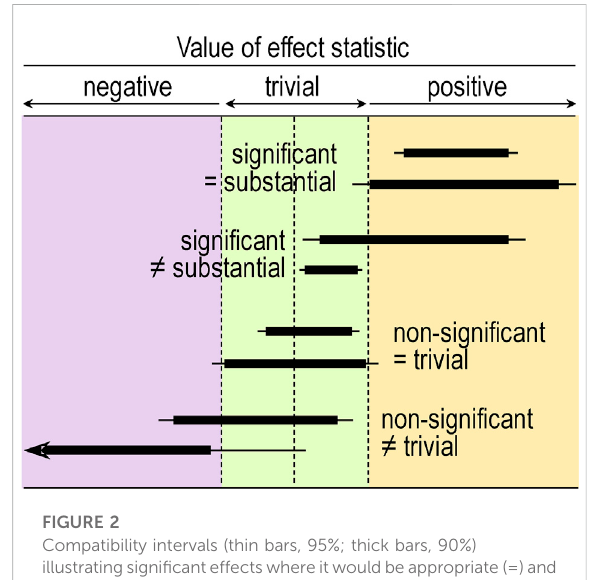
FIGURE 2 Compatibility intervals (thin bars, 95%; thick bars, 90%) illustratingsigni fi canteffectswhereitwouldbeappropriate(=)and inappropriate ( ≠ ) to conclude the effect is substantial, and non- signi fi cant effects where it would be appropriate and inappropriate to conclude the effect is trivial. The arrowhead indicates both compatibility intervals extending much further to the